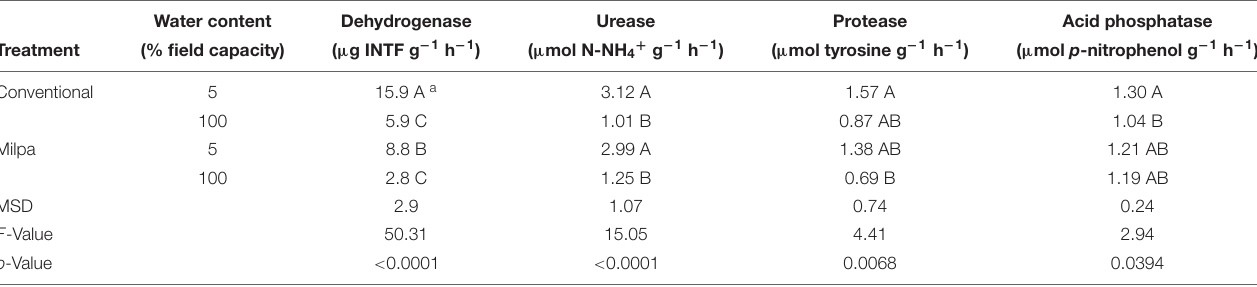
TABLE 4 | Enzymatic activity in soil cultivated conventionally, i.e., conventional tillage, crop residues removal, chemical fertilizer and herbicide application and monoculture of maize ( Zea mays L.), or cultivated with the organic milpa system, i.e., zero tillage, retention of crop residues, organic fertilizer application, weed management and crop rotation of maize, pumpkin ( Cucurbita sp.) and beans ( Phaseolus vulgaris L.), for 3 years. Water content